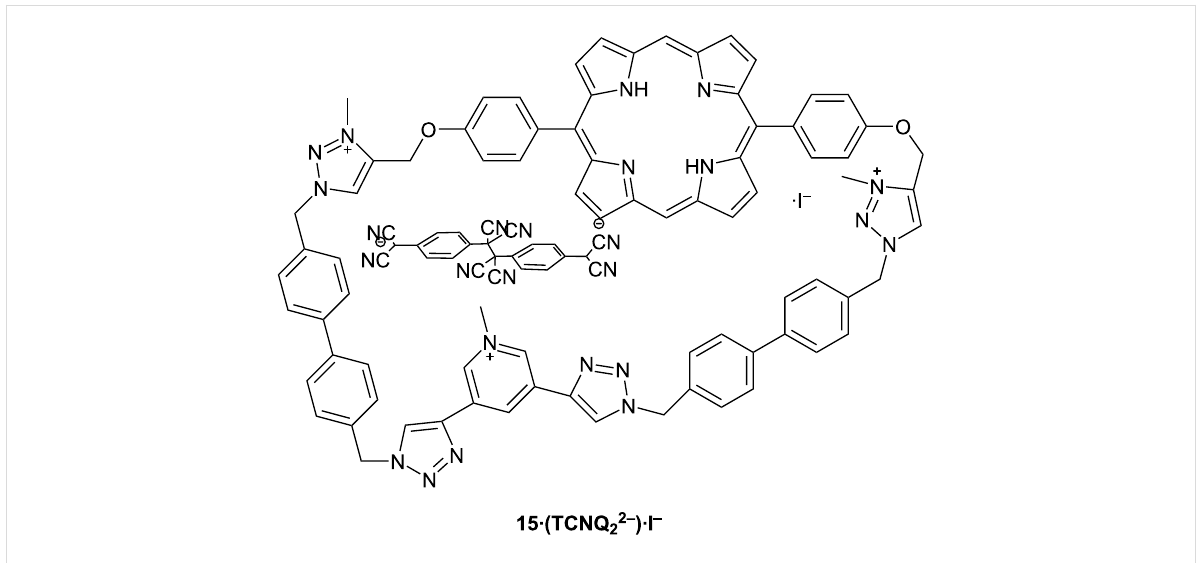
Figure 12: Chemical structure of compound 15 including the sigma-connected TCNQ